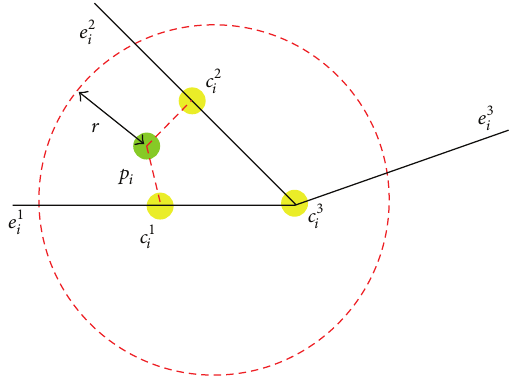
Figure 6: Illustration of CRS and CP.